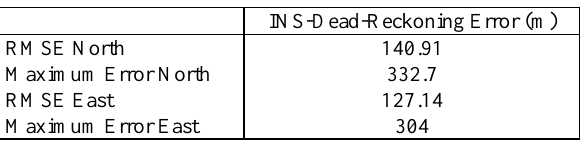
Table 1. INS dead-reckoning solution errors during 60 Secs of GNSS signal